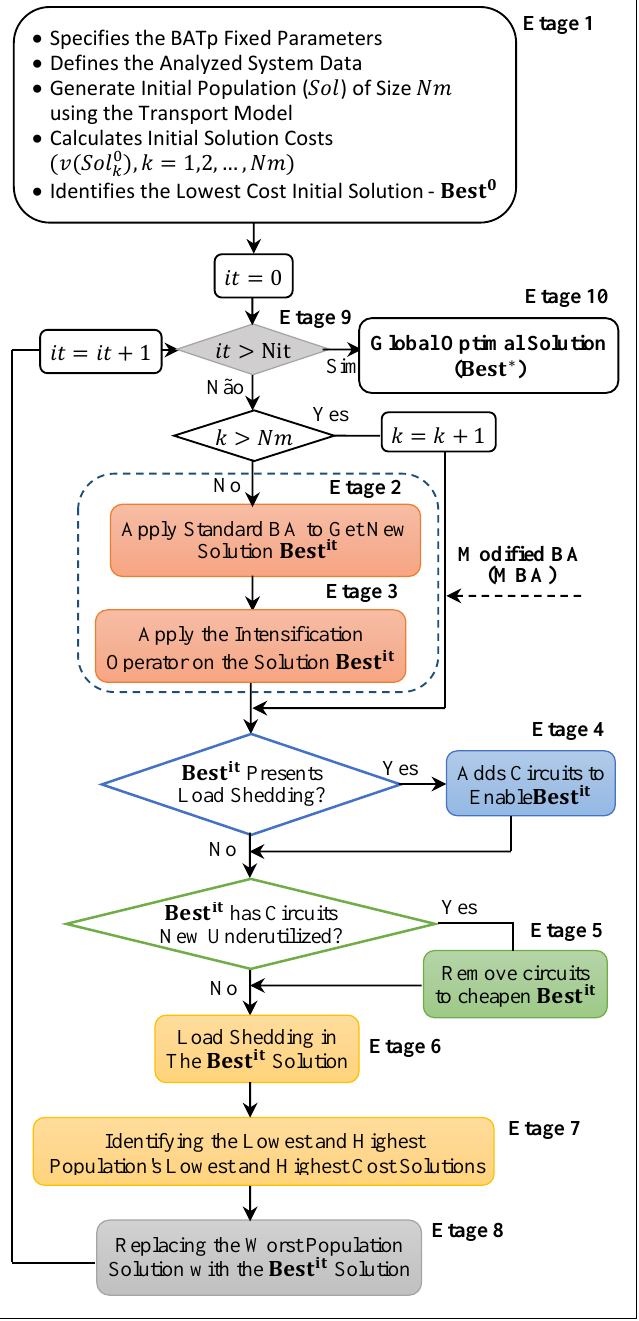
Figure 2: Simplified BATp optimizer flowchart. Source: Authors, (2022).